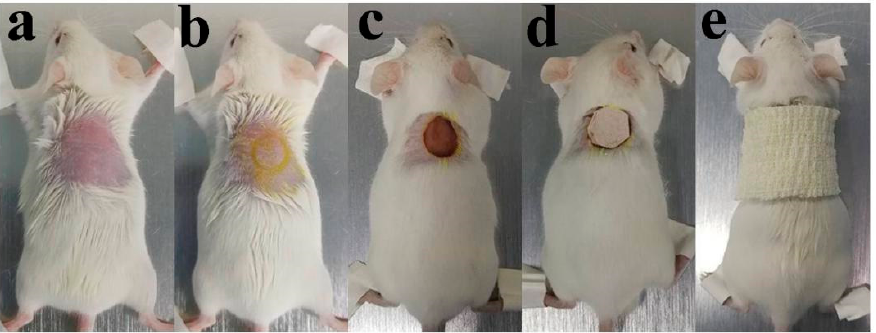
Figure 2. Process of the skin defect preparation: ( a ) fixed and shaved after anesthesia; ( b ) skin disinfection and mark on skin; ( c ) wound modeling; ( d ) dressing on wound; and ( e ) bandaging.